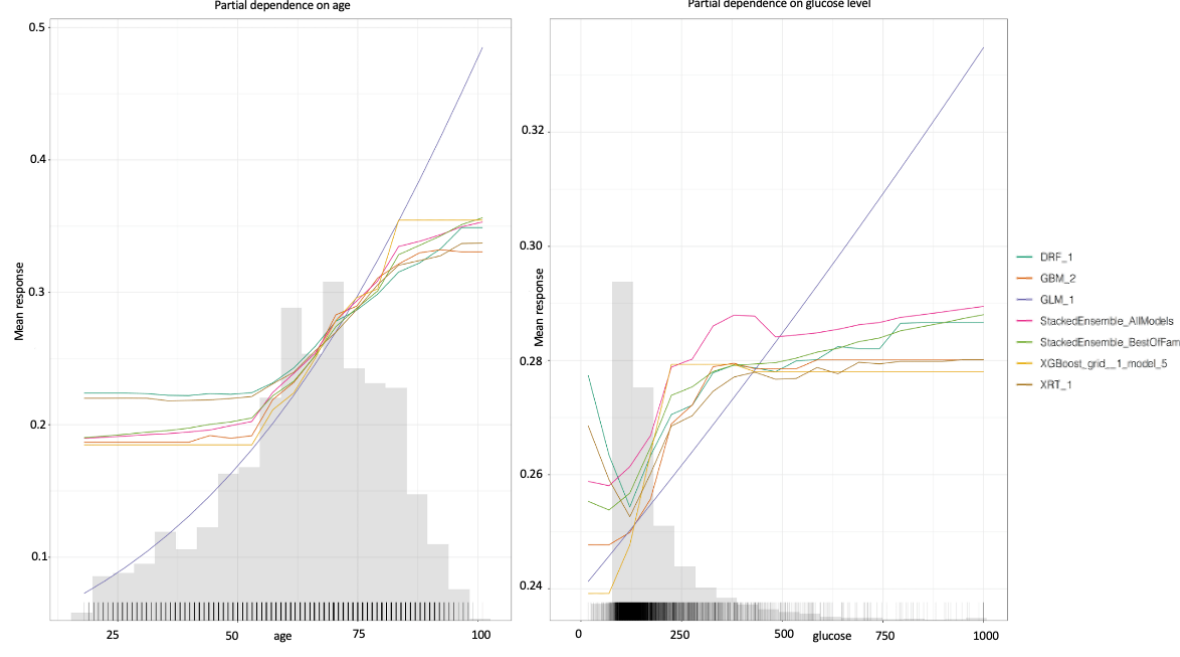
Figure 4. Partial dependence plots for age and glucose level. Partial dependence plots for the other variables are shown in Multimedia Appendix 2. Each line represents a different machine learning algorithm. DRF: distributed random forest; GBM: gradient boosting machine; GLM: generalized linear model; XGBoost, extreme gradient boosting; XRT: extremely randomized